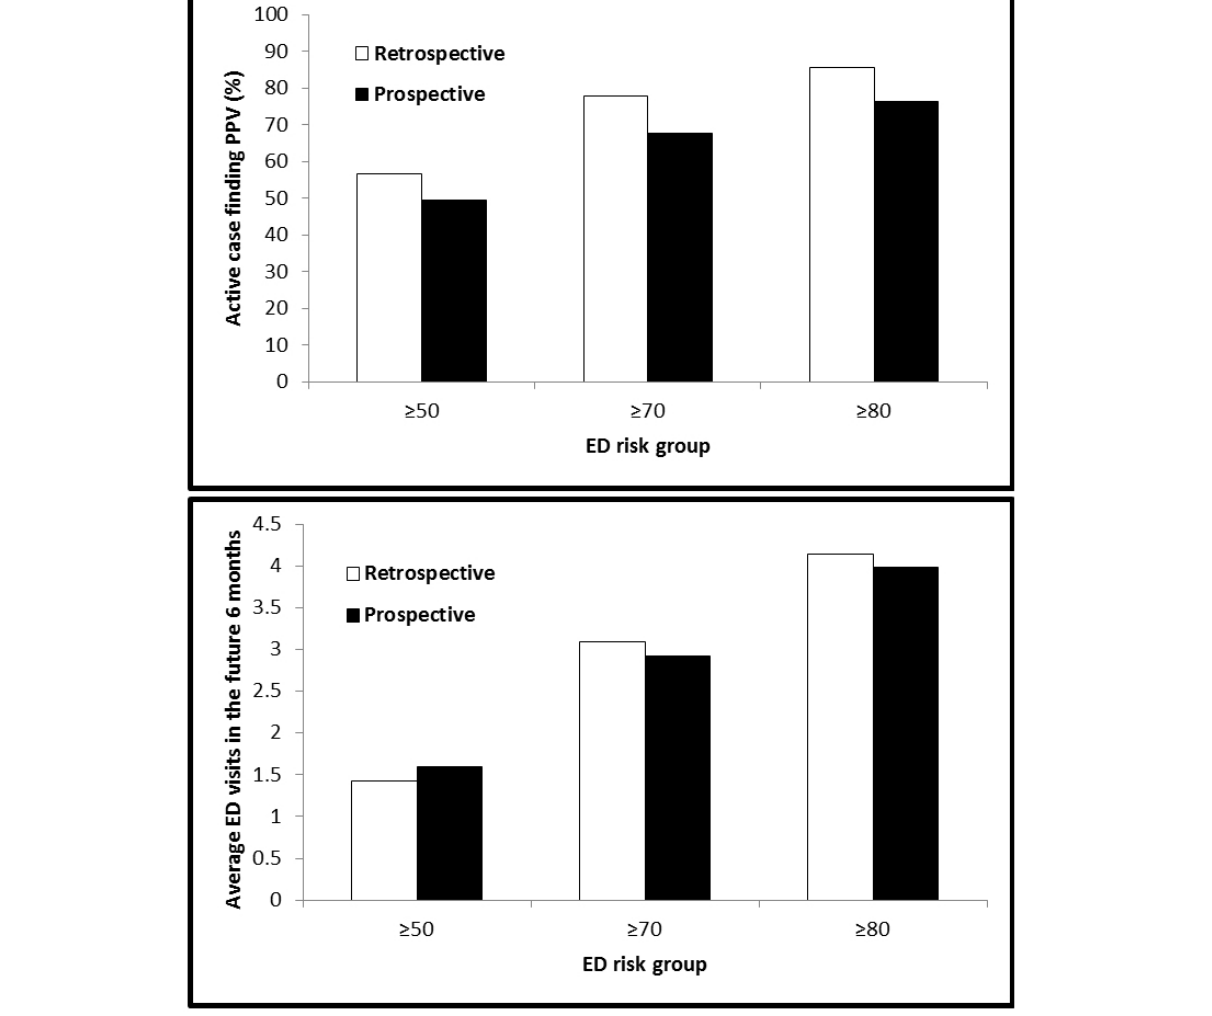
Figure 3. Active case finding algorithm effectively identified different risk group patients for future 6-month emergency (ED) utilization (upper panel shows X axis: different ED risk groups; Y axis: active case finding positive predictive value (PPV); and lower panel summarizes average ED uses at different ED risks in the future 6 months in both retrospective and prospective